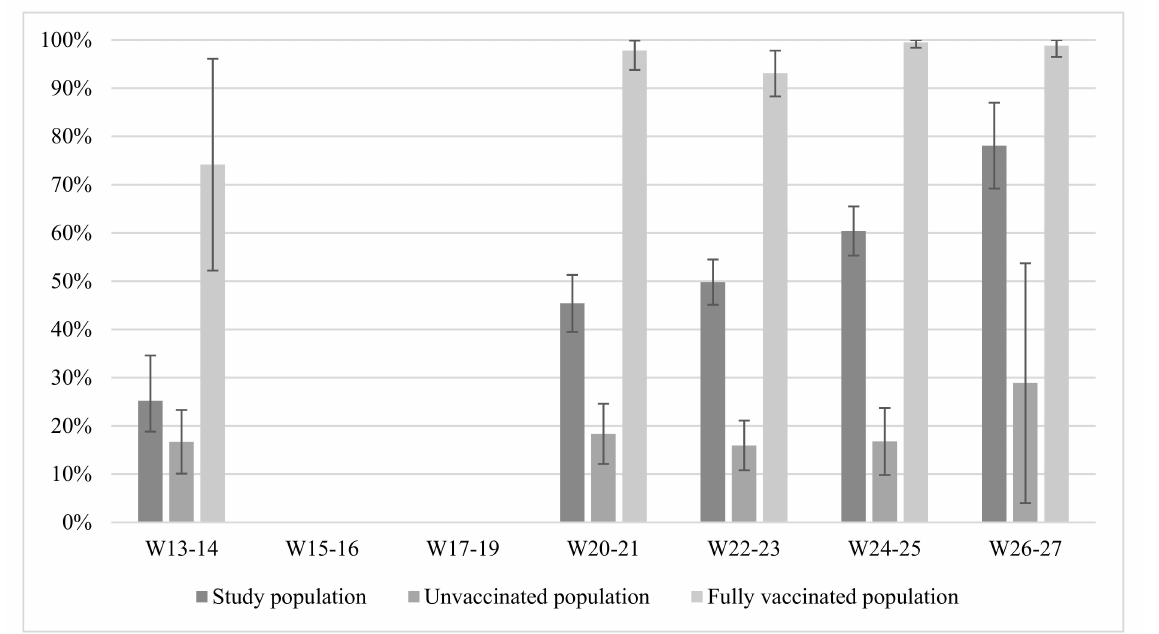
Figure 3. Prevalence of anti-SARS-CoV-2 antibodies by 2-week period of saliva collection.